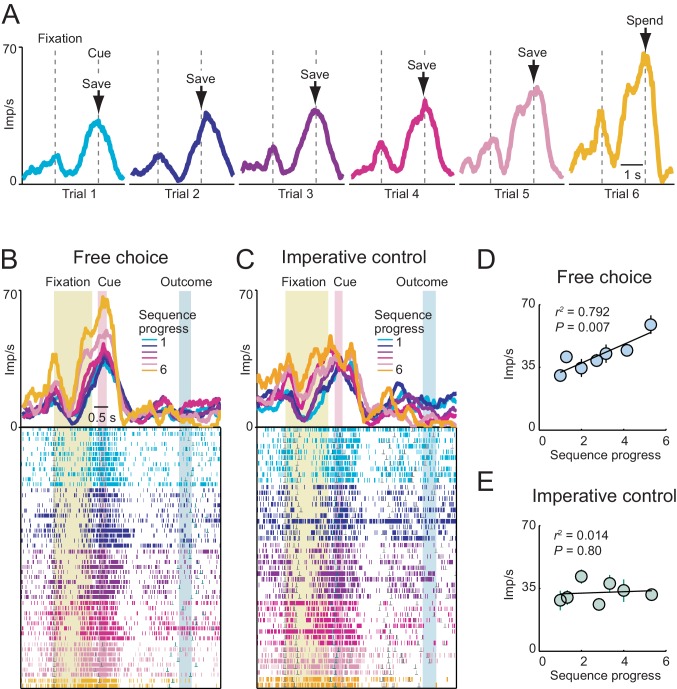
Gradually increasing activity related to sequence progress in a single amygdala neuron.(A) Neuronal response in the fixation and cue periods, plotted for each step of a six-trial choice sequence. Color indicates sequence progress. (B) Peri-event time histogram for the same neuron, aligned to fixation onset, sorted by sequence progress. Raster display: ticks indicate impulses, rows indicate trials; grey dots indicate event markers (labelled above graph). Activity in cue phase and preceding fixation phase reflected sequence progress, before the animal indicated its current-trial choice. Visual stimulation during fixation was constant over consecutive trials. Randomized cue positions precluded preplanning of action sequences. (C) The progress-related activity in the cue phase disappeared during performance of the imperative control task. (D, E) Linear regression (Equation 2) of trial-by-trial cue-phase activity on sequence progress in free choice and imperative task (error bars: s.e.m).